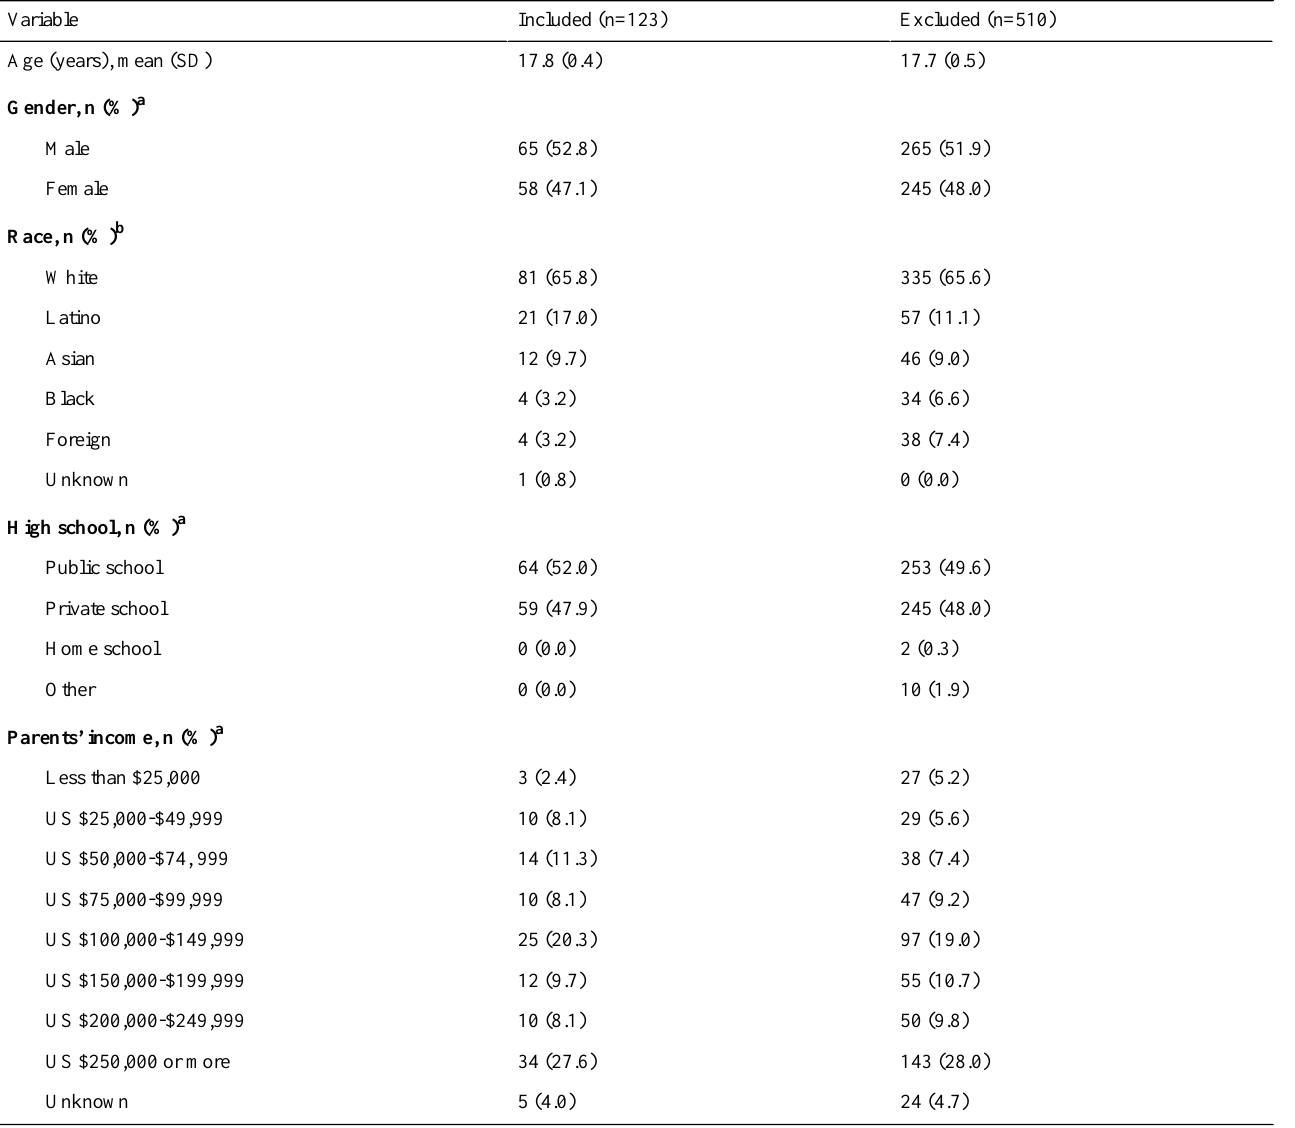
Table 1. Comparison of baseline characteristics between Fitbit participants included in this analysis and participants excluded based on compliance.